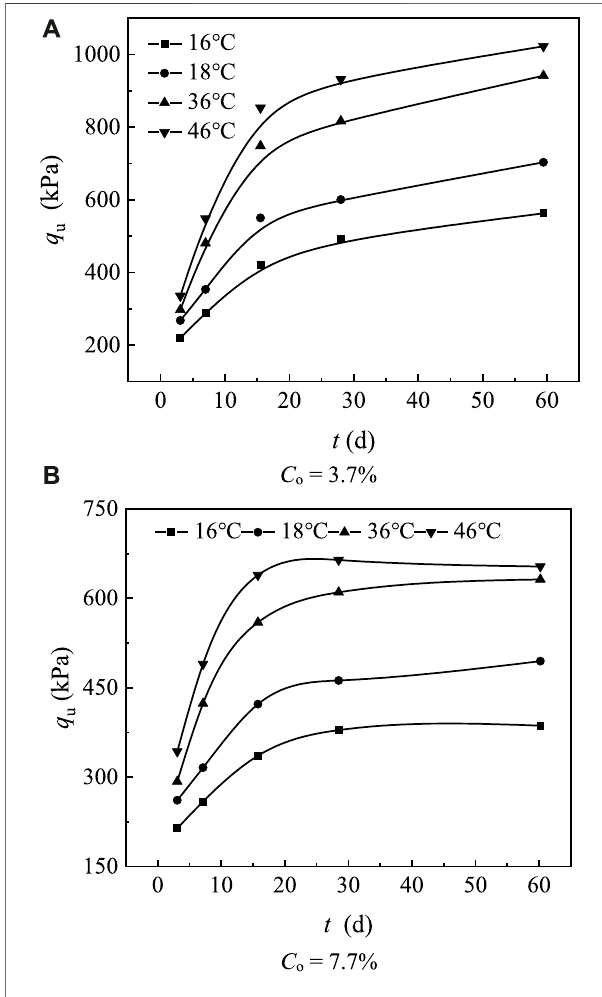
FIGURE 7 | Development of strength q u with curing time t for samples with different C o values cured at different temperatures. (A) C o = 3.7% (B) C o =